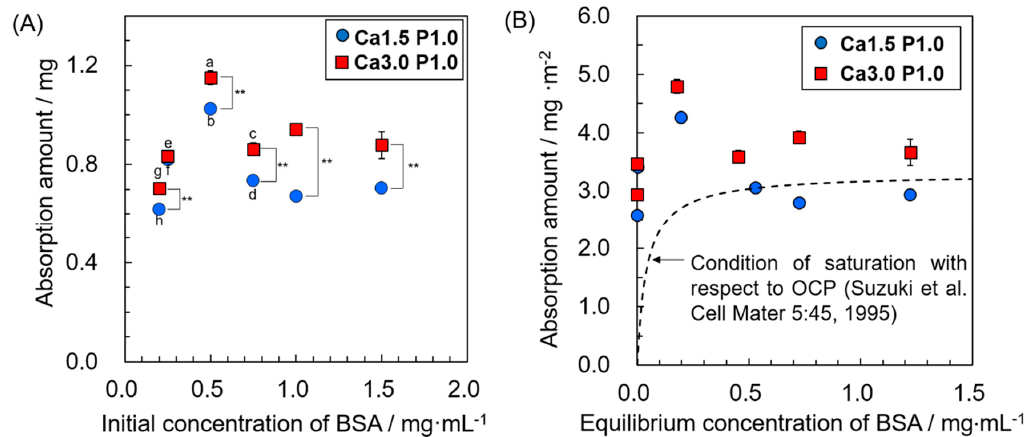
Figure 1. Adsorption isotherms of BSA onto octacalcium phosphate (OCP) plotted as adsorption amount as a function of initial BSA concentration ( A ) and adsorption amount per unit area of OCP as a function of BSA equilibrium concentration ( B ) in solutions containing 1.0 mM Pi ion and 1.5 or 3.0 mM Ca 2 + (Ca1.5P1.0 and Ca3.0P1.0, respectively). Mean values were obtained from three independent experiments (n = 3). Significant difference ( p < 0.01) for 0.20, 0.25, 0.75, 1.0 and 1.5 mg·mL − 1 BSA in a Ca3.0P1.0 and b Ca1.5P1.0 solution; c Significant difference ( p < 0.01) for 0.20, 0.25 and 1.0 mg·mL − 1 BSA